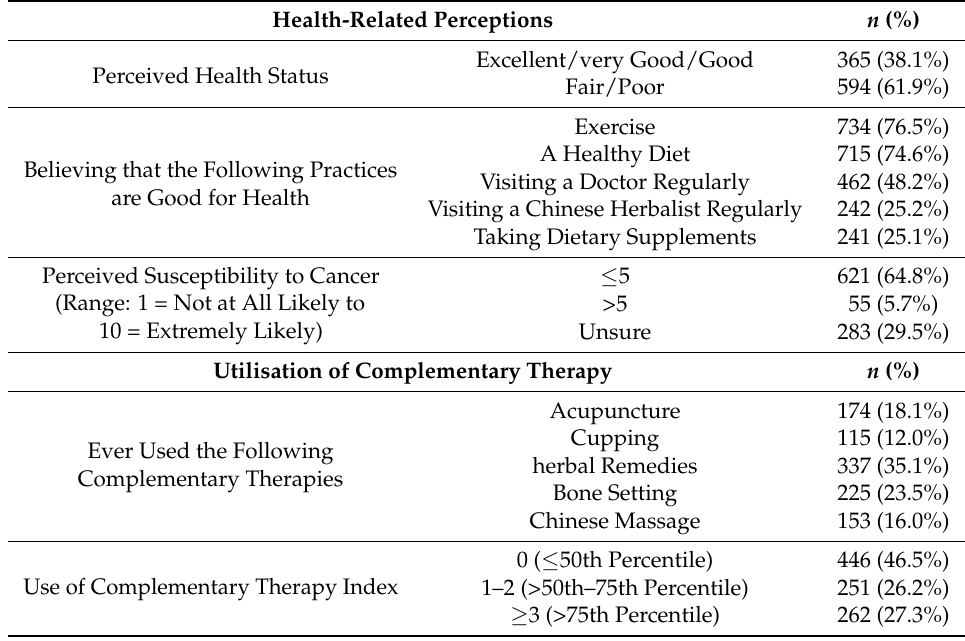
Table 2. Health-related perceptions and utilisation of complementary therapies.